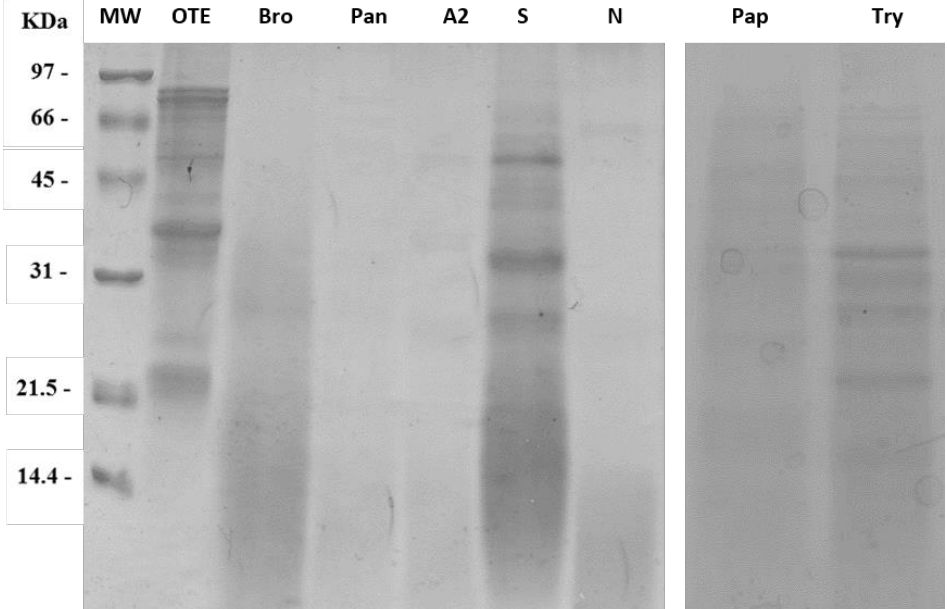
Figure 2. Comparison of digestion with different proteolytic enzymes. OTE stands for Okara Total Extract without any enzyme; Bro: Bromelain; Pan: Pancreatin; A2: Amano A2; S: Amano S; N: Amano N; Pap: Papain; Try: Trypsin. Isovolumic loadings allow to appreciate the different extraction yields obtained during simultaneous digestion and extraction. MW: Molecular Weight standard marker.